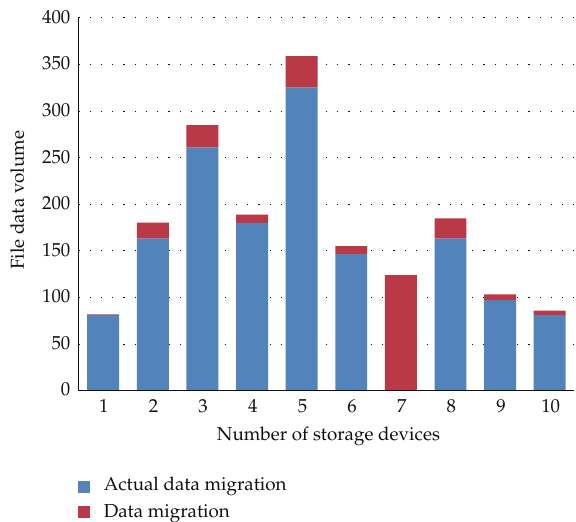
Figure 6: Data migration after deleting no. 7